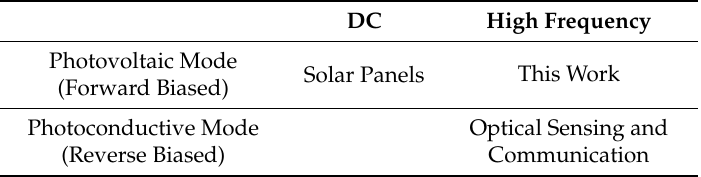
Table 1. Applications of various PV modes and operation